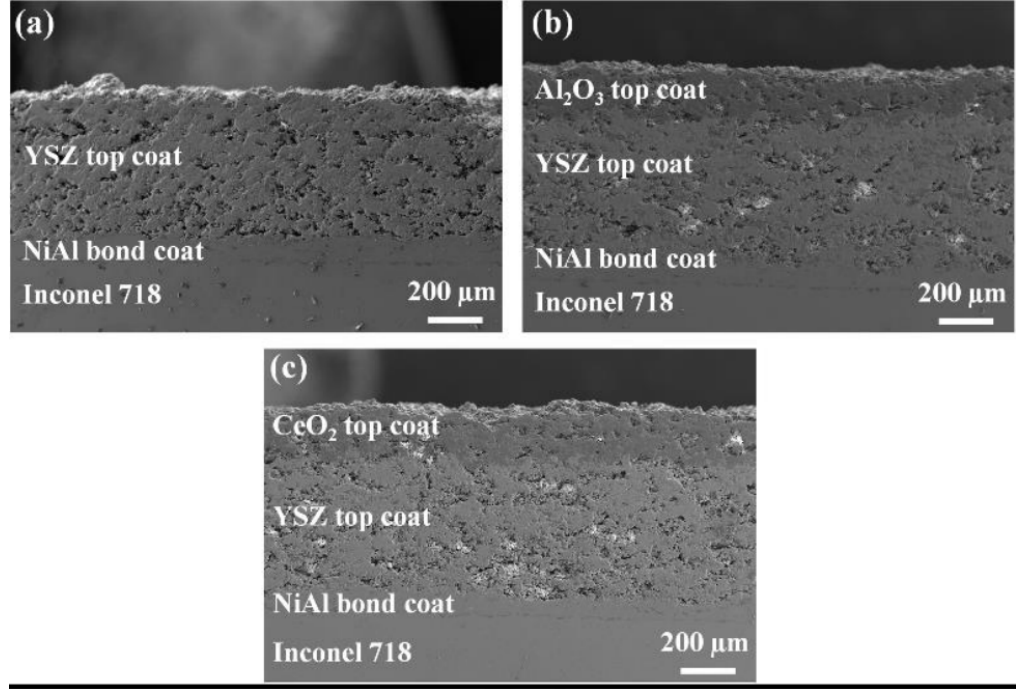
Figure 7. Low magnification FE-SEM images show the plasma-sprayed cross-sectional surface ( a ) NiAl/YSZ, ( b ) NiAl/YSZ/Al 2 O 3 and ( c ) NiAl/YSZ/Al 2 O 3 /CeO 2 [36].